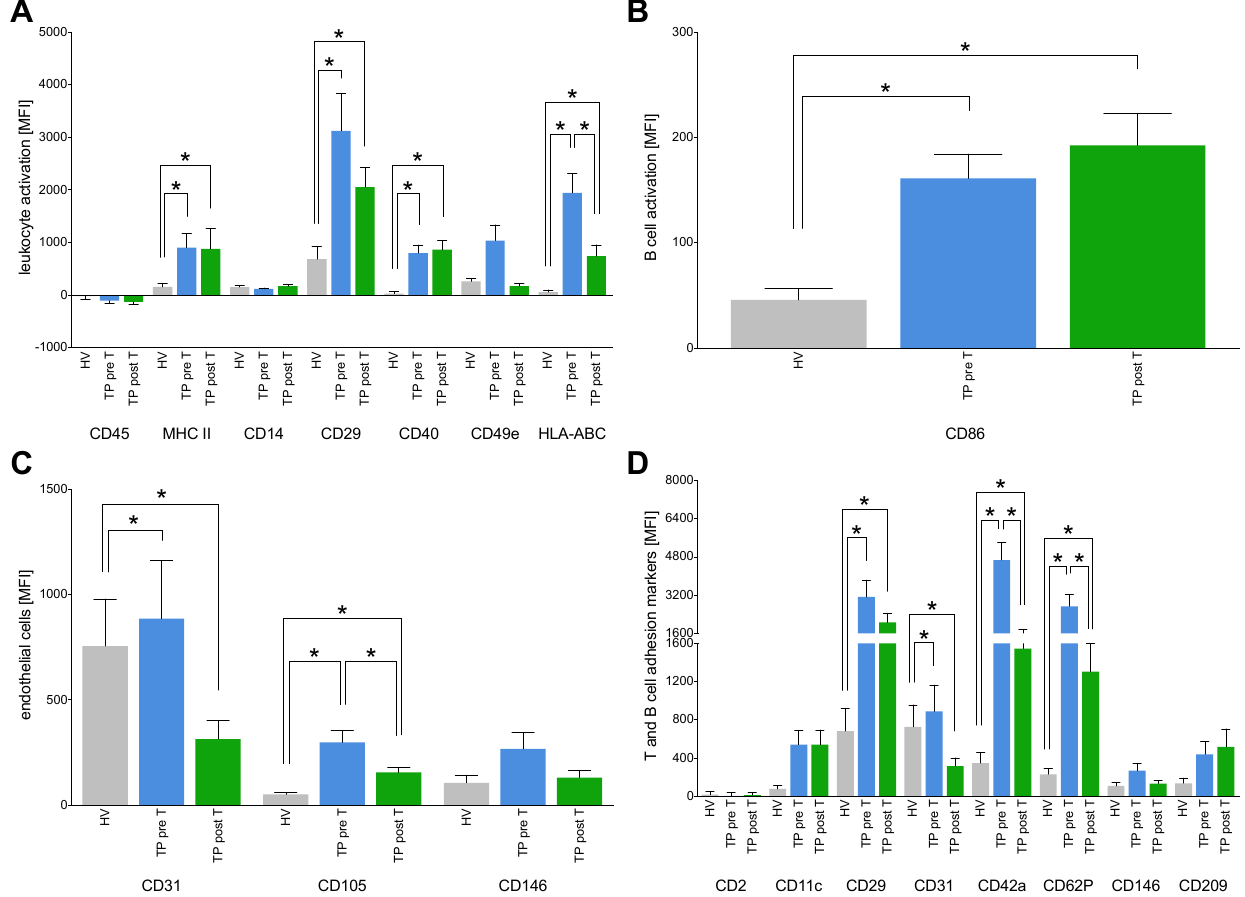
Figure 5. Expression of cluster of differentiation (CD) surface proteins on isolated extracellular vesicles (EVs) specific for leukocyte activation ( A ), B cells ( B ), endothelial cells ( C ), and T and B cell adhesion markers ( D ). The EVs derived from healthy volunteers (HV) and cholangiocellular carcinoma (CCA) tumor patients (TP) before (pre T) and after (post T) receiving a selective internal radiation therapy. The mean fluorescent intensity (MFI) is given as mean ± standard error of the mean. * p < 0.05 vs. indicated group.